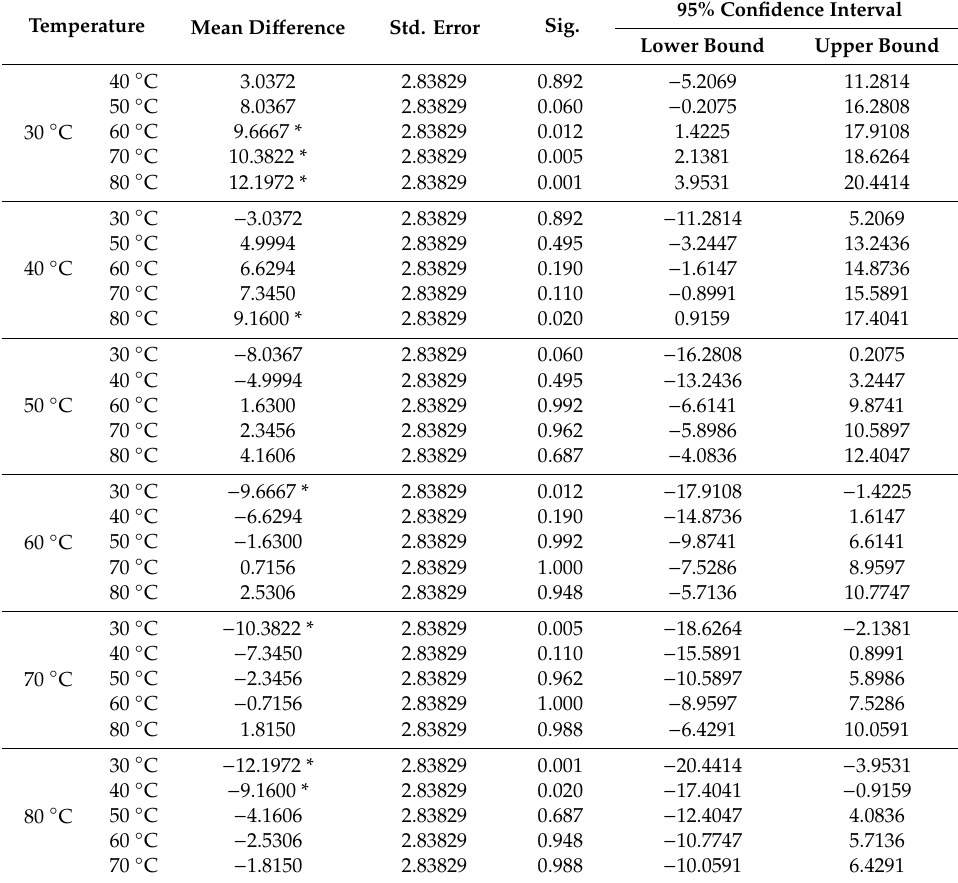
Table A1. Multiple comparisons of polyphenol oxidase (PPO) activity at di ff erent